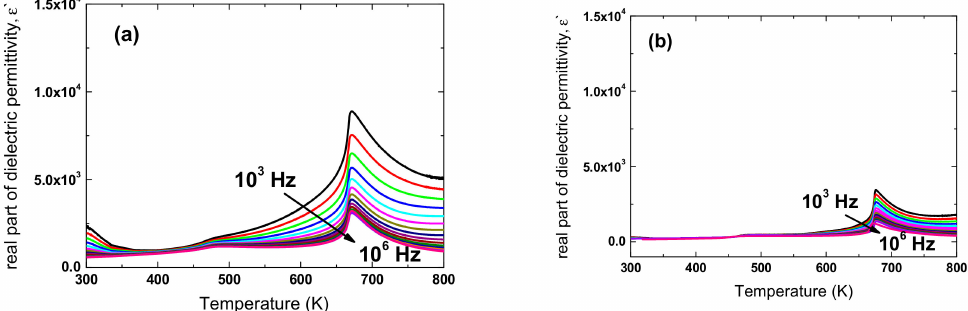
Figure 9. Dielectric permittivity as function of temperature measured at various frequencies of measuring field, for KNN ceramics obtained from 25 h ( a ) and 100 h ( b ) milled